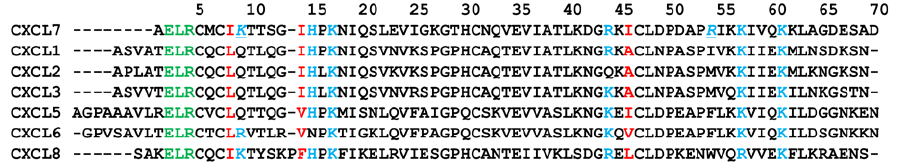
Figure 1. Sequence alignment of neutrophil-activating chemokines. The conserved “ELR” motif is shown in green. Basic residues that mediate GAG and receptor interactions and hydrophobic residues that mediate receptor interactions for CXCL7 identified in this study are shown in blue and red, respectively. The corresponding residues in other chemokines are likewise highlighted. Residues K9 and R54 shown to be involved in binding only in CXCL7 are italicized and underlined. Receptor binding and activity measurements have shown that CXCL7 binds CXCR2 with nanomolar (nM) affinity, indicating that the monomer is a potent agonist [17]. Presently, nothing is